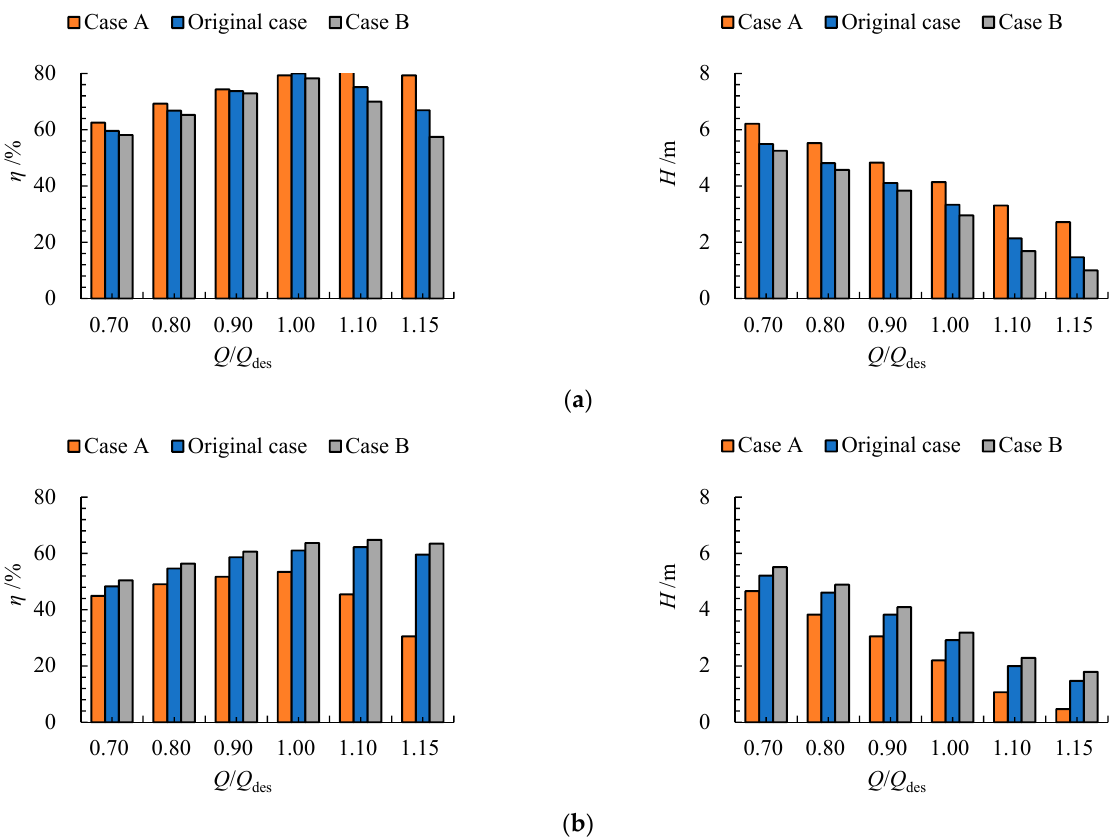
Figure 10. The pump performance of three airfoil cambers under ( a ) forward and ( b ) reverse condition.